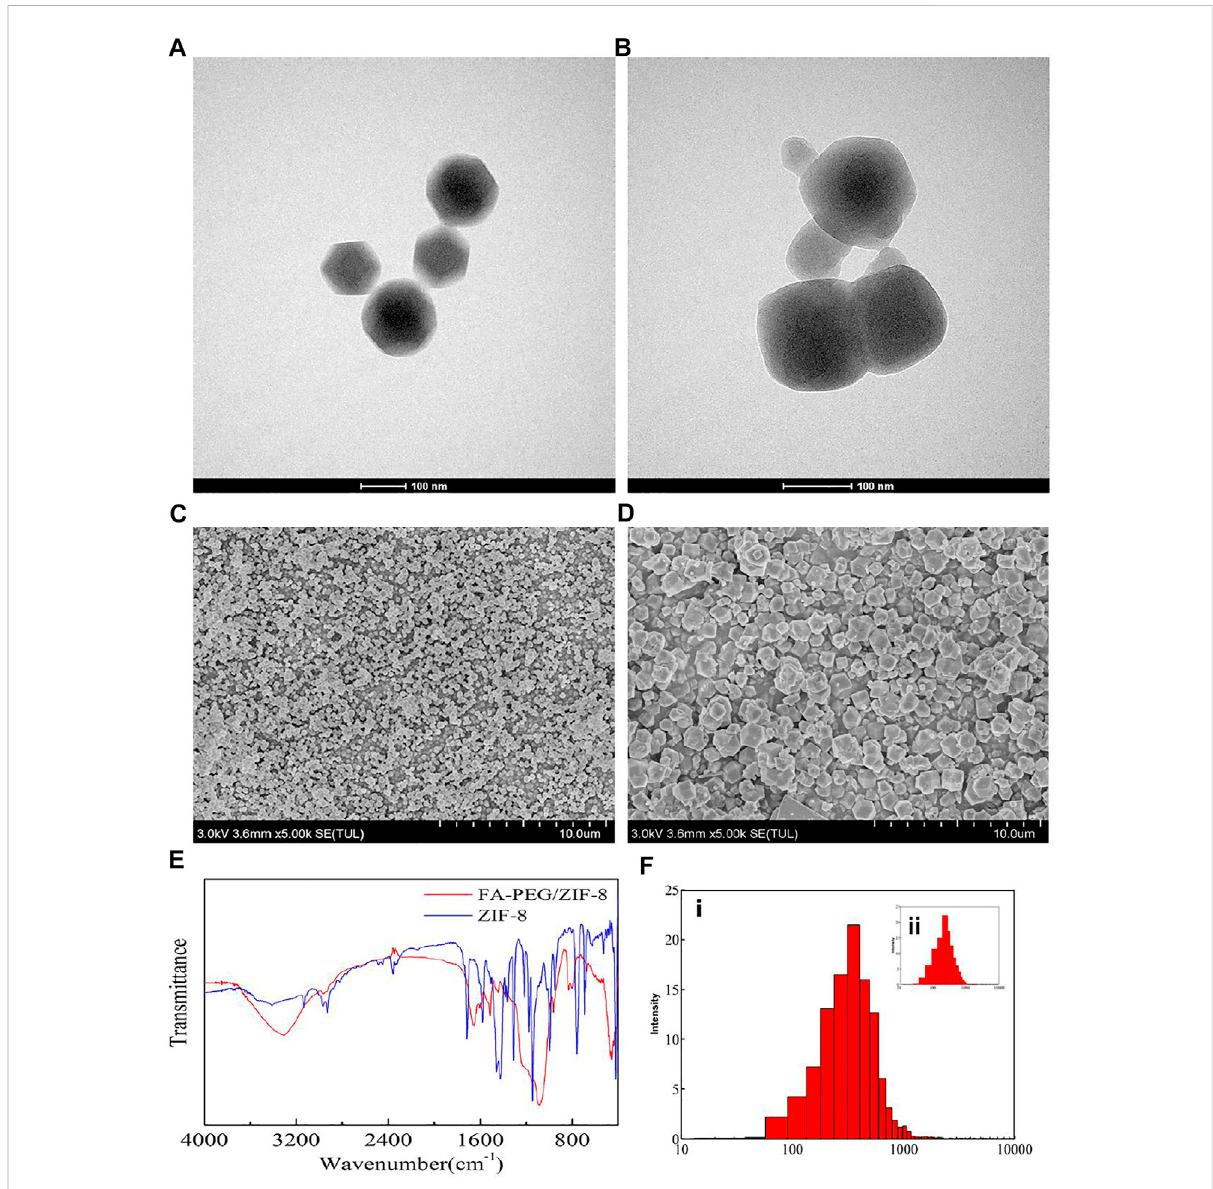
FIGURE 1 Characterization of ZIF-8 and FA-PEG/ZIF-8. TEM and SEM images of ZIF-8 (A,C) and FA-PEG/ZIF-8 (B,D) . FTIR spectra (E) and DLS (F-i) of FA- PEG/ZIF-8, DLS (F-ii) of